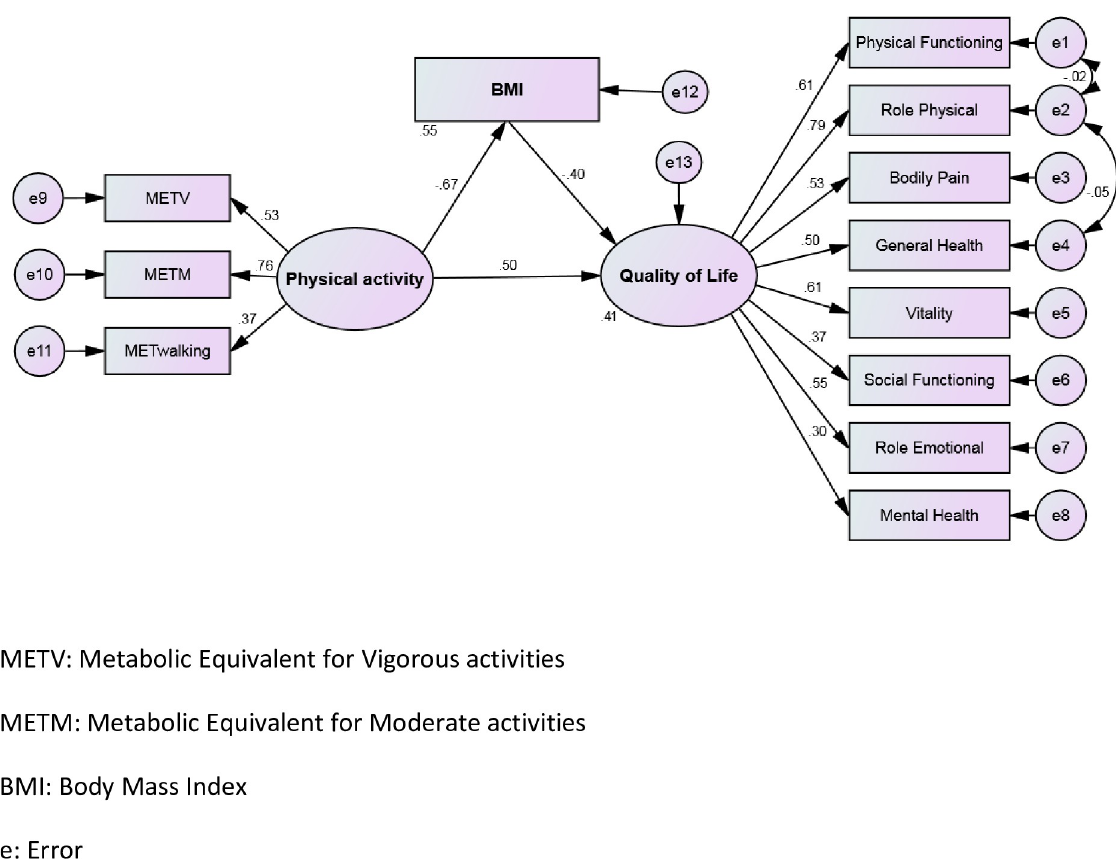
Fig 2. Standard coefficients of the modified